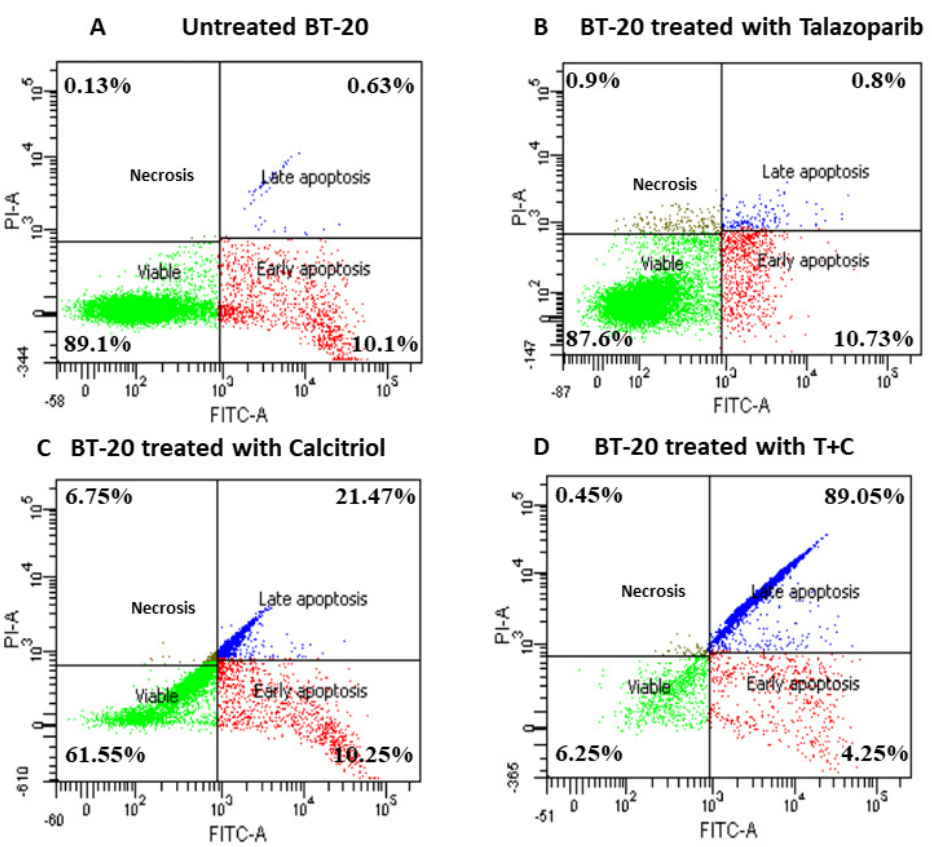
Figure 7. Annexin V/FITC − PI flow cytometry analysis of BT − 20. Cells (1 × 10 6 cells/mL) treated with talazoparib (Panel B ), calcitriol (Panel C ), and combined treatment (Panel D ) for 24 h vs. untreated control (Panel A ). Cells were dual − stained with Annexin V − FITC and propidium iodide, and the dot plot of BT − 20 with different treatments was generated. Each data set is a representative plot of three independent experiments (green dots represent viable cells, red dots represent early apoptosis, blue dots represent late apoptosis and brown dots represent necrosis), while percentages are the mean value of three independent experiments. Raw data can be found in Supplementary File S7.